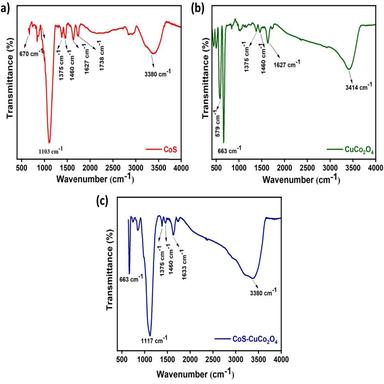
FT-IR analysis of CoS, CuCo2O4 and CoS-CuCo2O4.